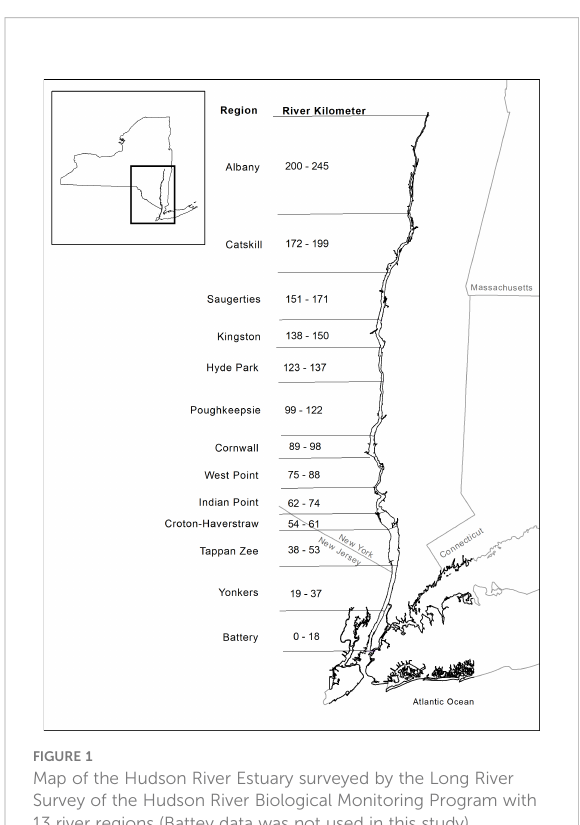
FIGURE 1 Map of the Hudson River Estuary surveyed by the Long River Survey of the Hudson River Biological Monitoring Program with 13 river regions (Battey data was not used in this